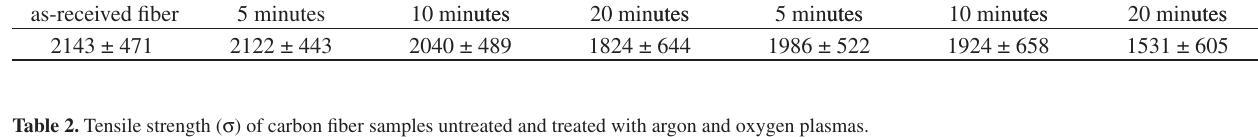
Table 1. Tensile strength ( σ ) of carbon fiber samples untreated and treated with hydrochloric and nitric acids. Hydrochloric Acid Treatment σ (MPa)